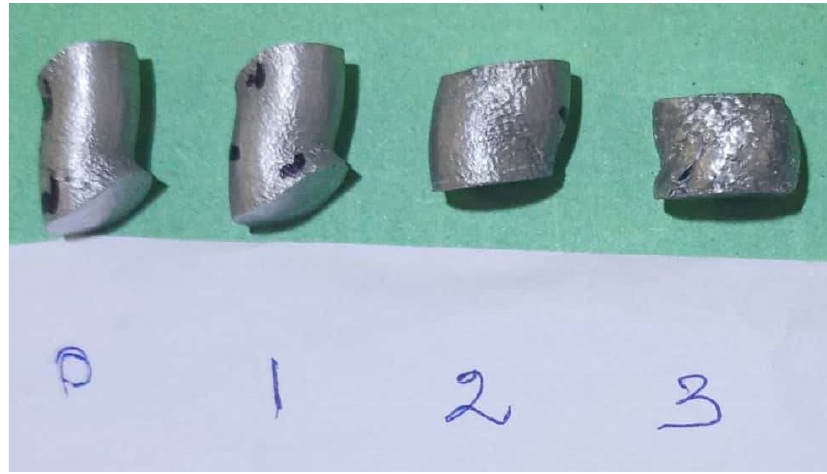
Figure 17. Distorted compression test specimens.